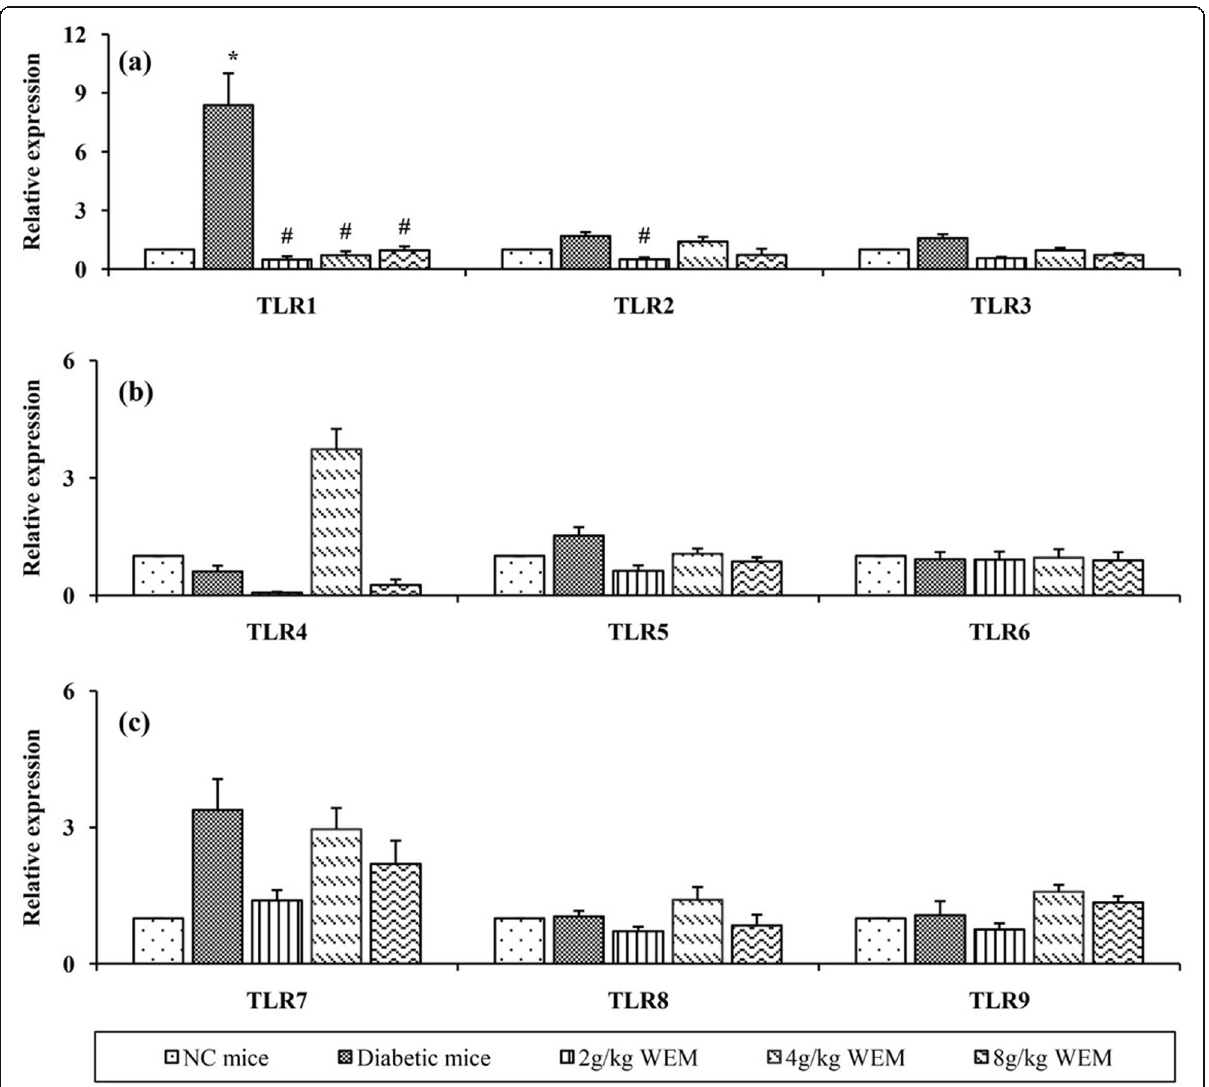
Fig. 6 TLR mRNA relative expression pattern of skeletal muscle ( a , b and c ). RNA from skeletal muscle was isolated and quantitative real-time PCR (qPCR) was performed to assess the differences in TLR mRNA expression when the diabetic mice were administered with WEM. Data are shown as intensity ± SEM ( n = 6to5). * P < 0.05, **P < 0.01, NC mice vs. Diabetic mice; # P < 0.05, ## P < 0.01, WEM vs. Diabetic